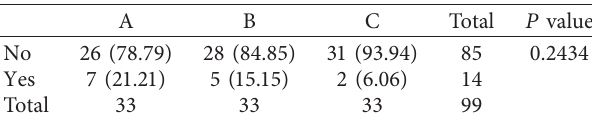
Table 5: Adverse